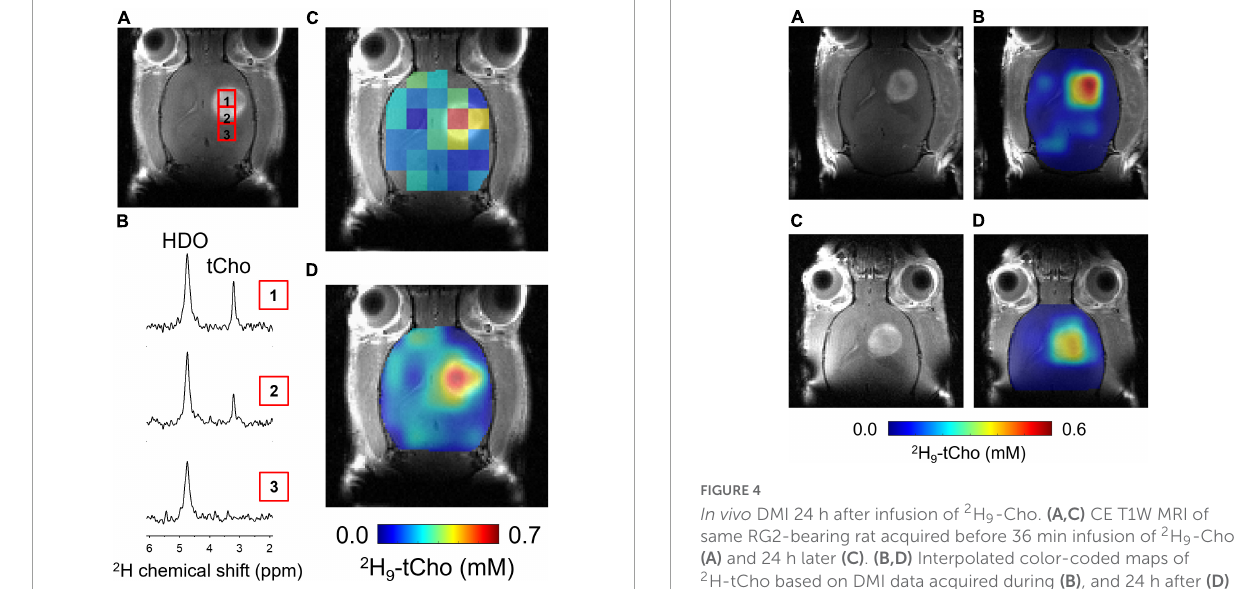
FIGURE3 In vivo DMI during infusion of 2 H 9 -Cho. (A) Coronal slice of CE T1W MRI from brain of RG2-bearing rat, showing the tumor lesion and individual voxel positions selected from the 2 H MRSI grid. (B) Individual 2 H spectra from voxel positions indicated on MRI shown in panel (A) . (C) Color-coded 2 H MRSI grid overlaid on anatomical MRI. (D) Interpolated color-coded map based on data shown in panel (C) . Color scale applies to both C and F. tCho, total choline; HDO, natural abundant 2 H-labeled H 2 O.